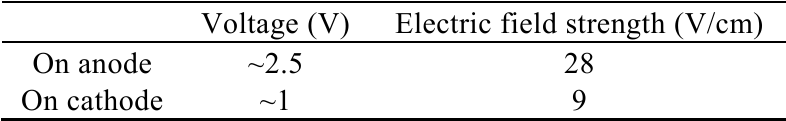
Table 3. Condition of the first gas bubble